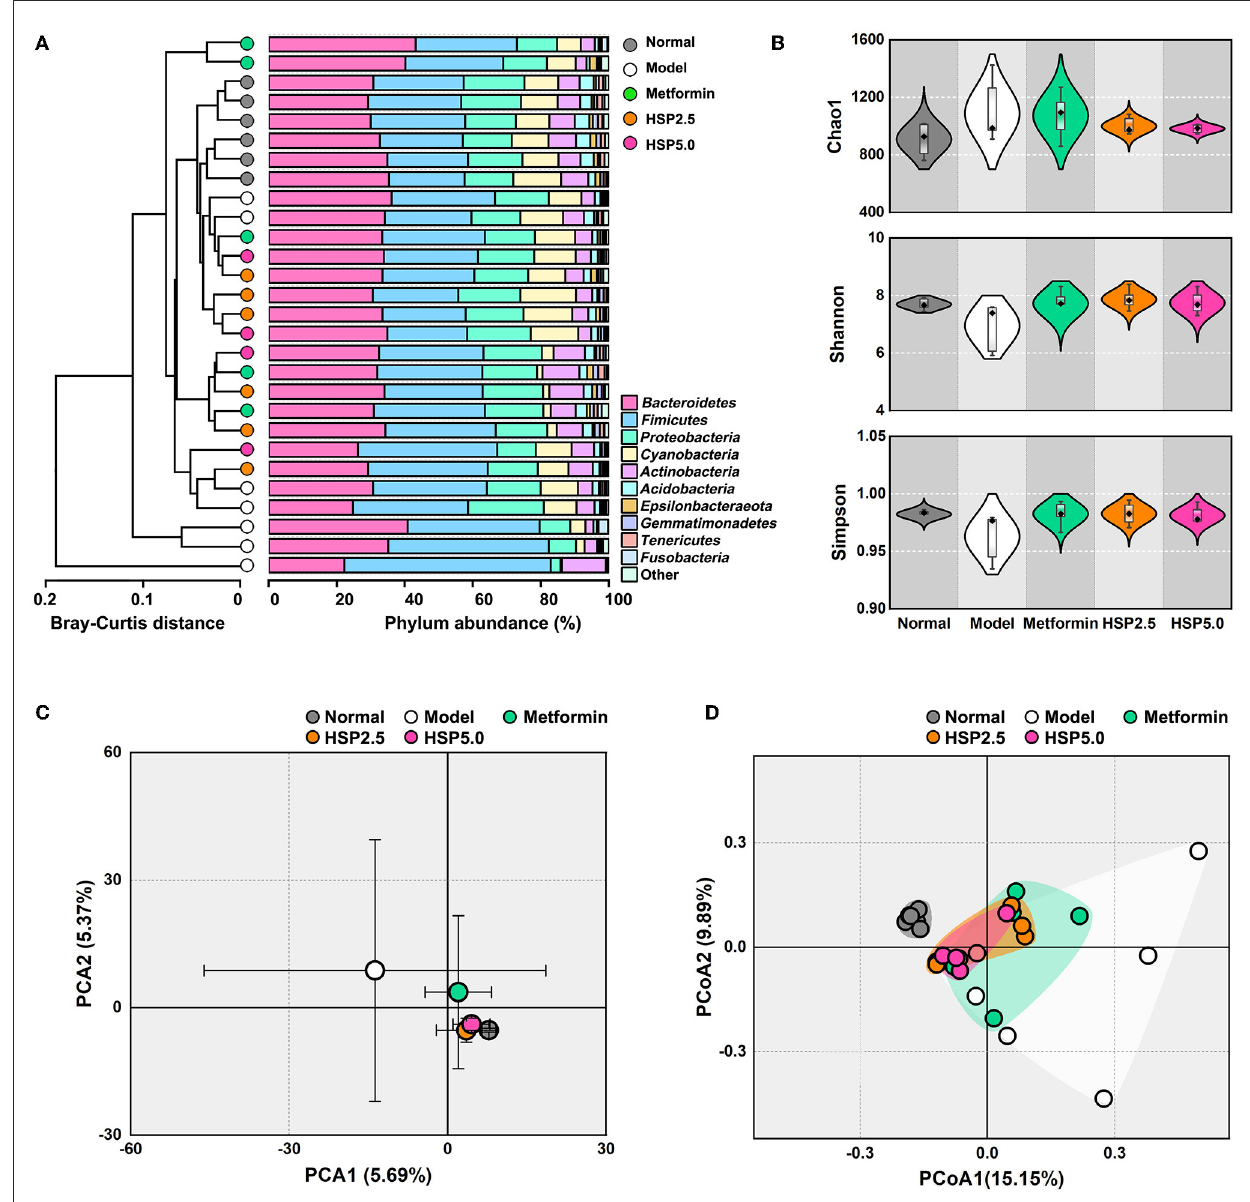
FIGURE2 Analyses of alpha and beta diversities among groups. (A) Phylum structure of gut microbiota. The evolutionary tree was built with the Bray–Curtis distance using the UPGMA method. (B) Simpson, Shannon, and Chao indexes. (C) PCA. The error bars of each sample indicate the standard deviations at PC1 and PC2, respectively. (D) PCoA. The sample distributions are shadowed with different colors for each